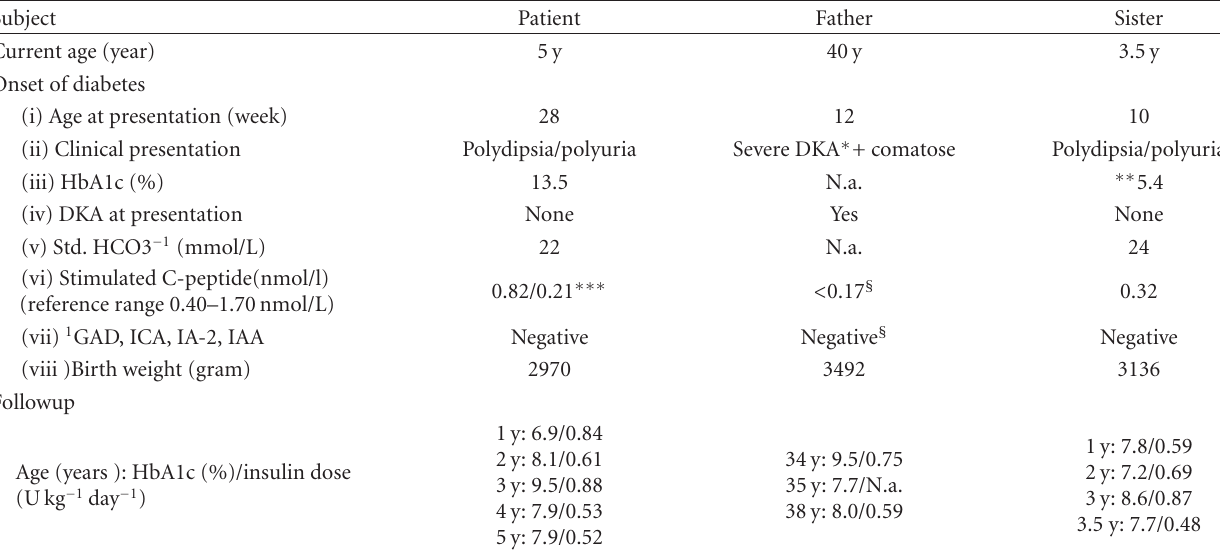
Table 1: Characteristics of the